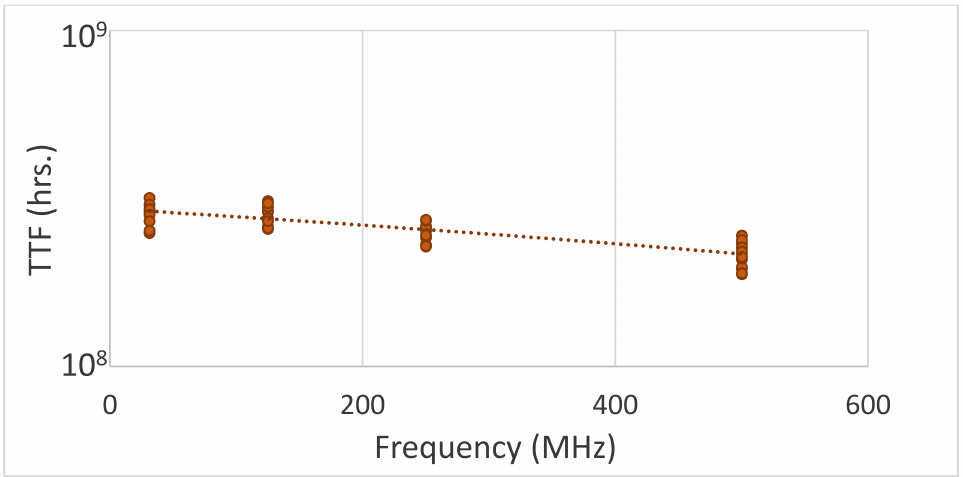
Figure 14. Three TTF to frequency plots averaged over the frequency. The decrease in TTF resembles the results received using ROs.